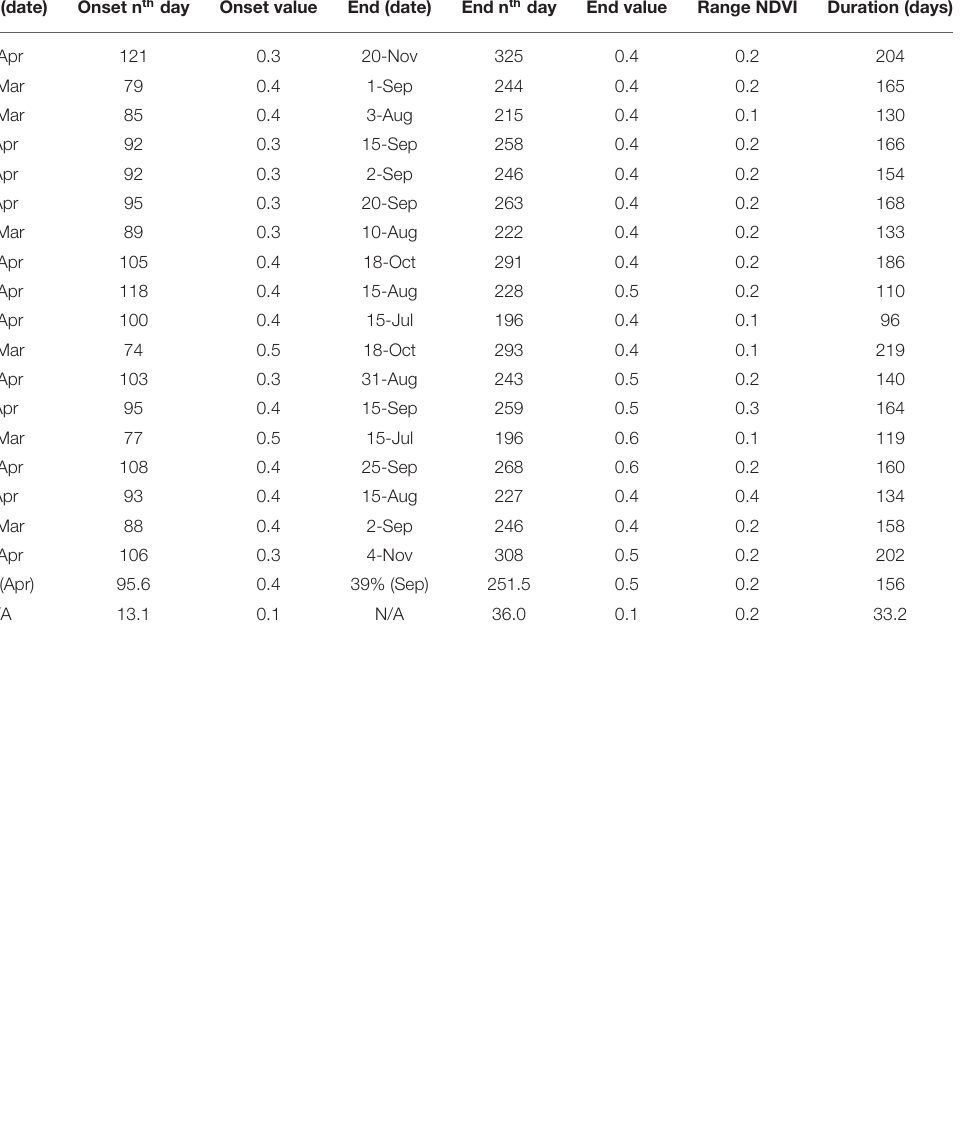
TABLE 3 | Grassland phenological metrics for the Karamoja region in Uganda for the period 2000–2017.